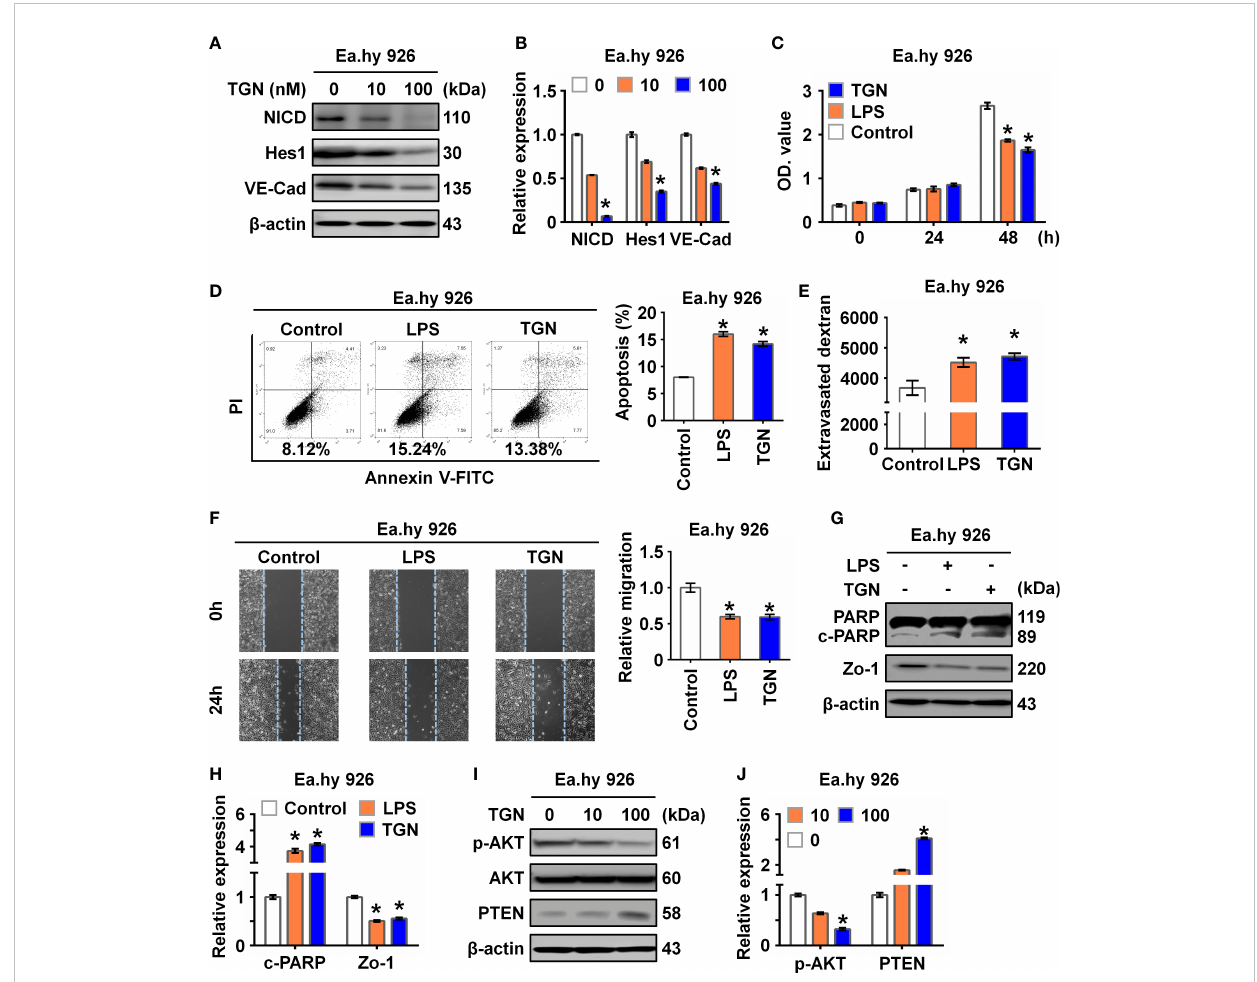
FIGURE 2 Inhibition of NICD impairs endothelial function. (A, B) The expression of NICD, Hes1, and VE-Cad in Ea.hy 926 cells were tested by Western blot after treating with different concentrations of TGN for 24 (h) Representative images (A) and three experiments replicates (B) were displayed. (C) CCK8 assay was used to evaluate the proliferation of Ea.hy 926 cells treated with LPS and TGN for 24 (h) (D) The apoptosis of Ea.hy 926 cells regulated by LPS or TGN was tested with Annexin V-FITC/PI staining by fl ow cytometry. (E) The endothelial permeability was determined by the transwell assay after being treated with LPS and TGN for 24 (h) Quantitative analysis was performed by measuring FD40 fl uorescence intensity relative to the control. (F) The migration of Ea.hy 926 cells was tested by wounding healing assay after being treated with LPS and TGN for 24 (h)